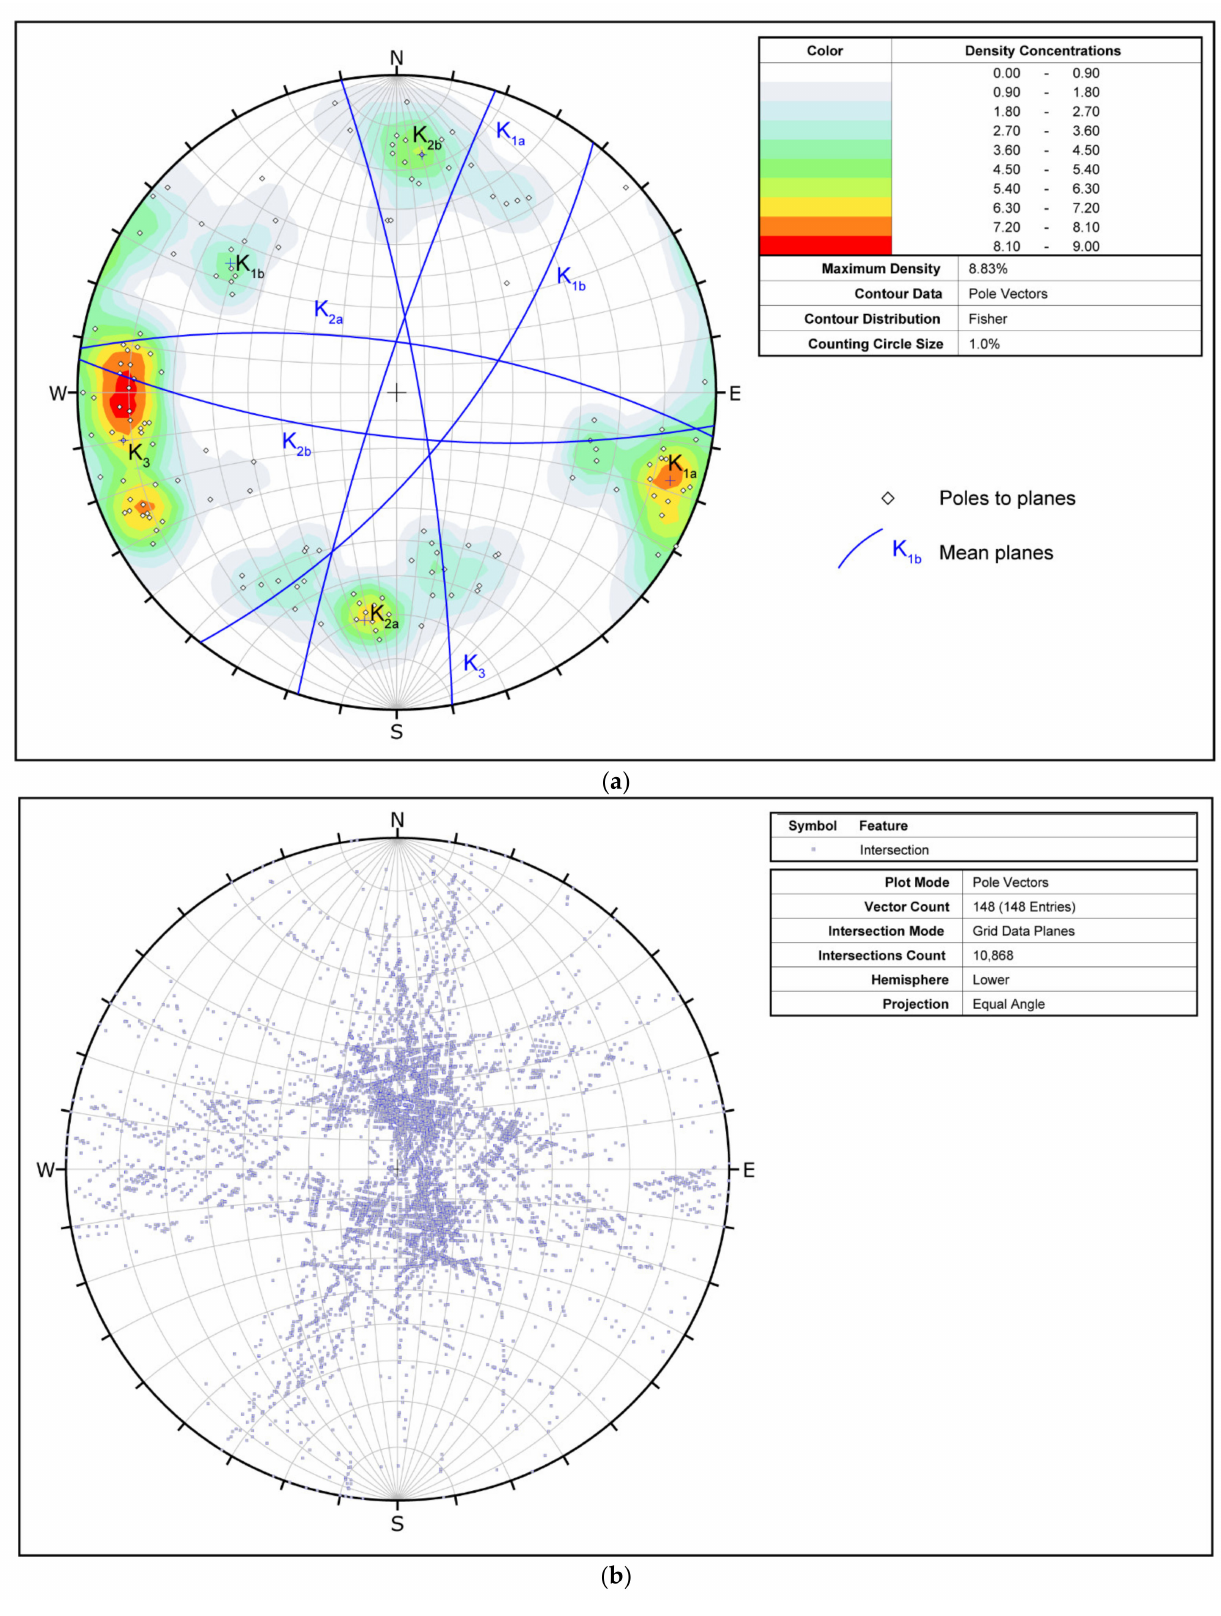
Figure 8. ( a ) Equal angle projection (lower hemisphere) of the measured discontinuities (poles) and contours. The blue lines are the mean planes of each recognized system; ( b ) Equal angle projection of all the intersections among planes (blue